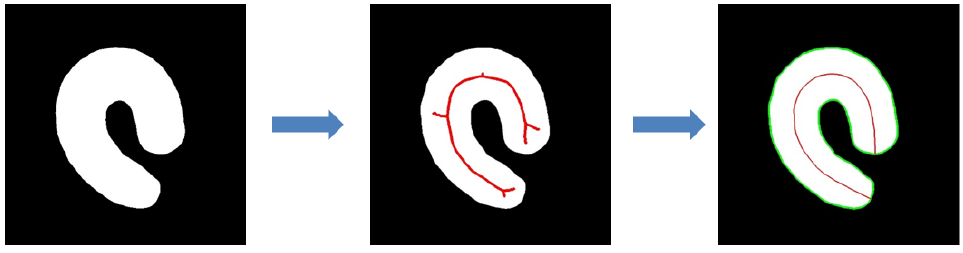
Figure 6. Rendering of the mesh pruning algorithm.